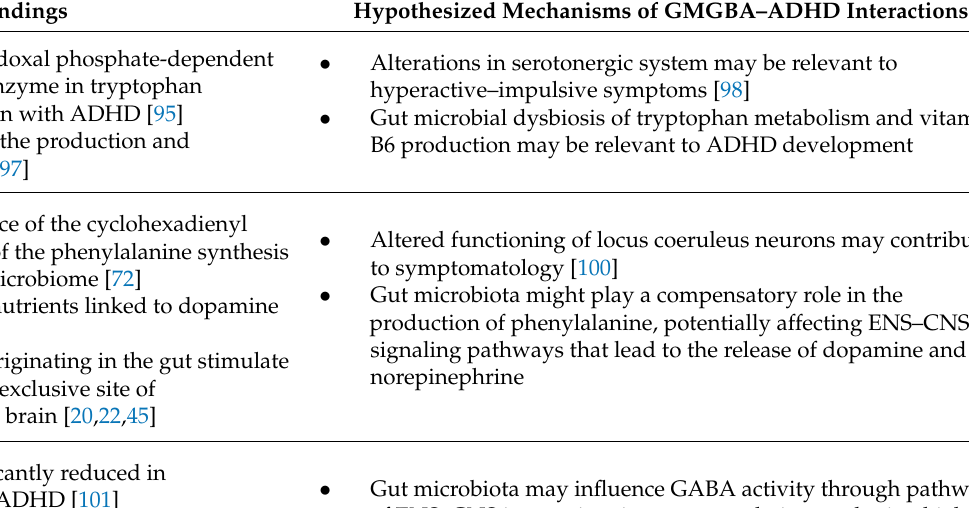
Table 3. Relevant findings related to neuroactive gut microbial metabolites and hypothesized mechanisms of metabolite influence in GMGBA–ADHD